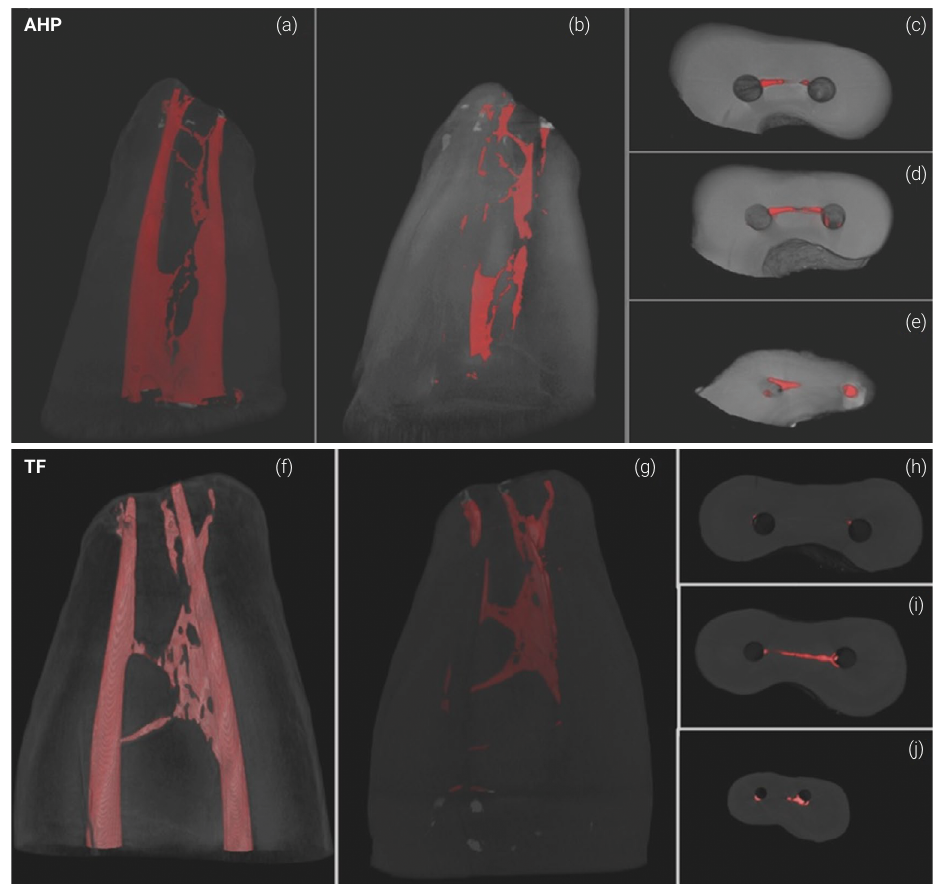
Figure 1. Three-dimensional images of the obturated root canal (a, f), remaining filling material (b, g) and transversal section images of the cervical (c, h), middle (d, i) and apical (e, j) thirds of the AHP and TF